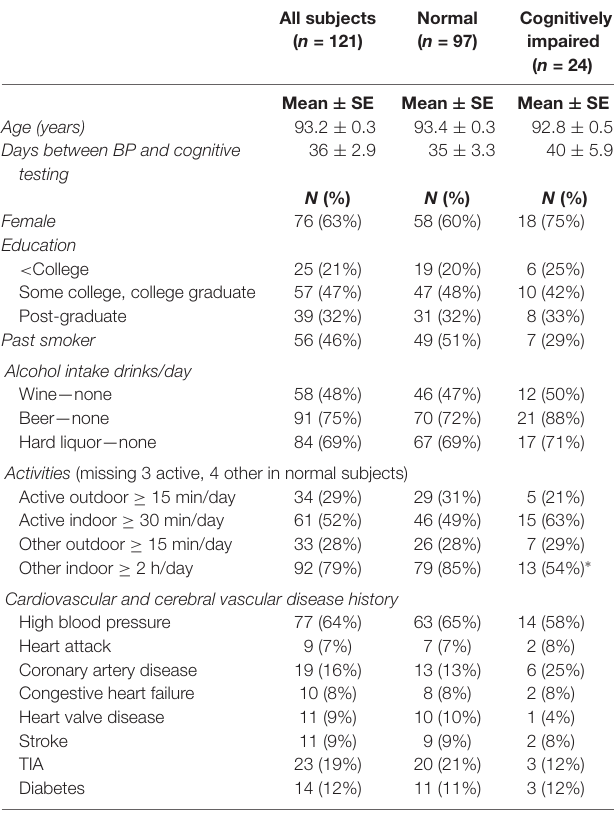
TABLE 1 | Characteristics of 121 subjects with 24-h ambulatory blood pressure monitoring